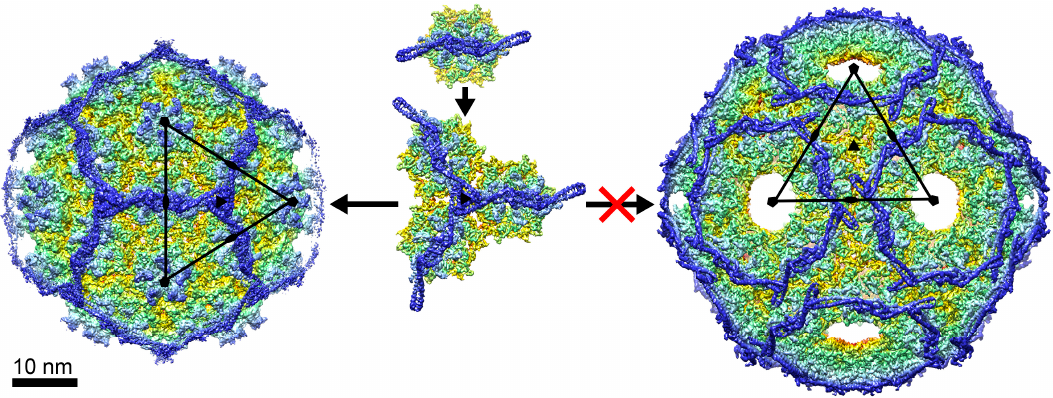
6 Figure 6. Model for the Sid-induced capsid redirection. Initially, Sid dimers interact with gpN hexamers, forming a Sid-gpN complex ( top ). Once Sid trimerizes and forms a Sid-gpN trimer complex ( middle ), continued growth of the shell is only compatible with formation of a T = 4 lattice ( left ). If the Sid-gpN complexes were to assemble into a T = 7 lattice ( right ), trimerization of Sid would be impossible, leading to a highly unfavorable configuration of Sid.